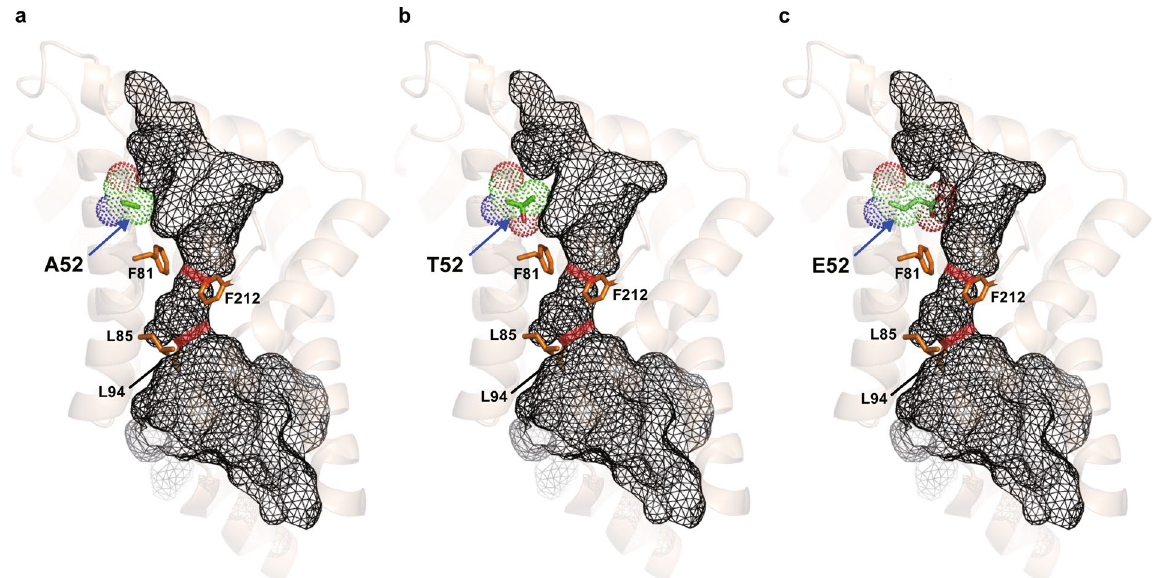
Figure 5. 3D model structure of the formate transporter (TON_1573) in the parent strain ( a ) and A52T mutant ( b ) and A52E mutant ( c ) strains. The two predicted constriction sites in the closed central pore are highlighted in red. The F81/F212 and L85/L94 residues were predicted to contribute to the constriction sites (Supplementary Figure 4), are highlighted in